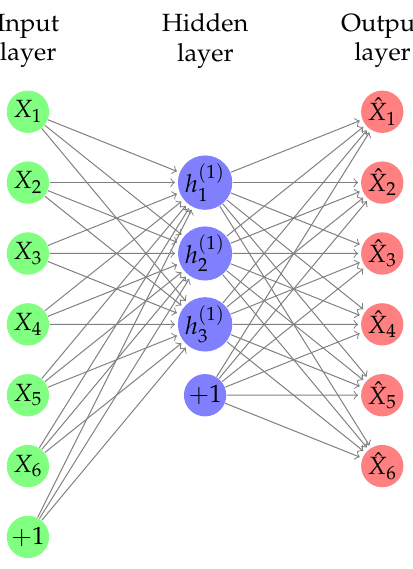
Figure 3. Autoencoder with single hidden